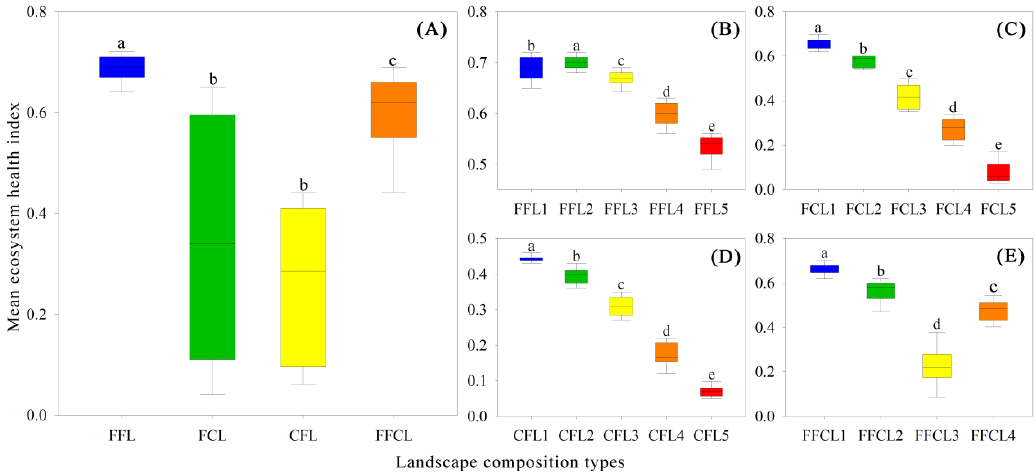
Figure 7. Ecosystem health differences between landscape composition types. ( A ) differences be- tween four landscape types; ( B ) difference between five subtypes of forestland + farmland landscape; ( C ) difference between five subtypes of forestland + construction land landscape; ( D ) difference be- tween five subtypes of construction land + farmland landscape; ( E ) difference between four subtypes of forestland + farmland + construction land landscape. FFL, forestland + farmland landscape;